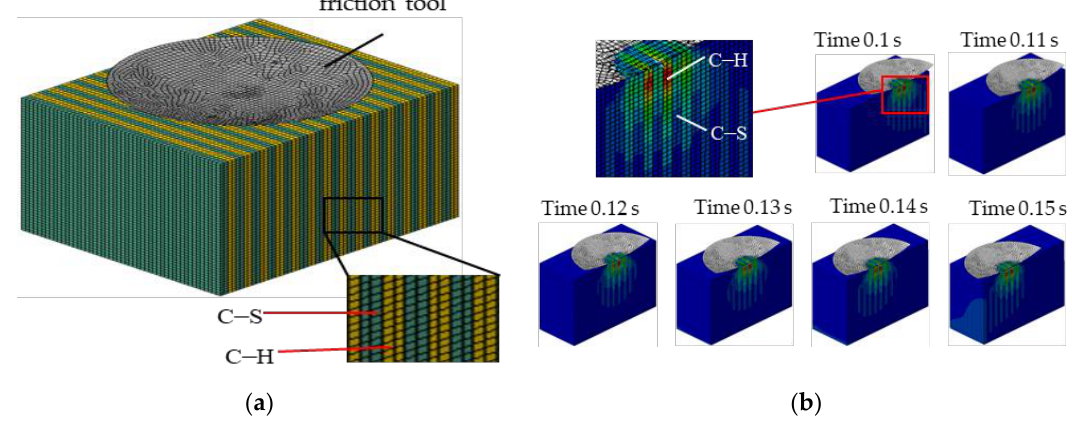
Figure 2. Finite element (FE) model of dry sliding process of BHSIMs. ( a ) FE model of BHSIMs, ( b ) Mises stress distributions sliding process at different timepoints.